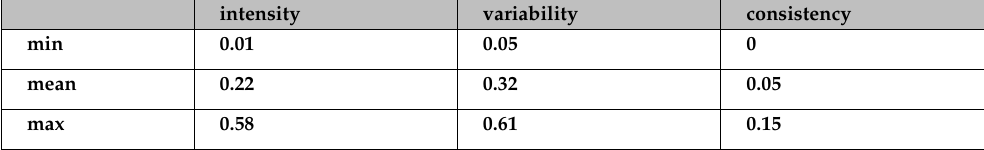
Table 2: Description of the three attributes for the average day of the